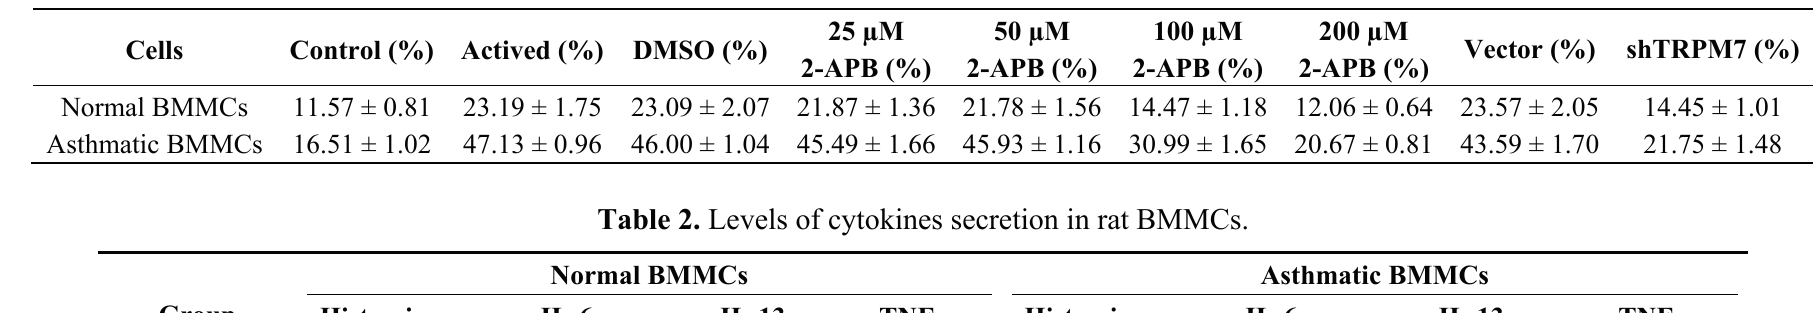
Table 1. Levels of β -hexosaminidase activity in rat BMMCs.